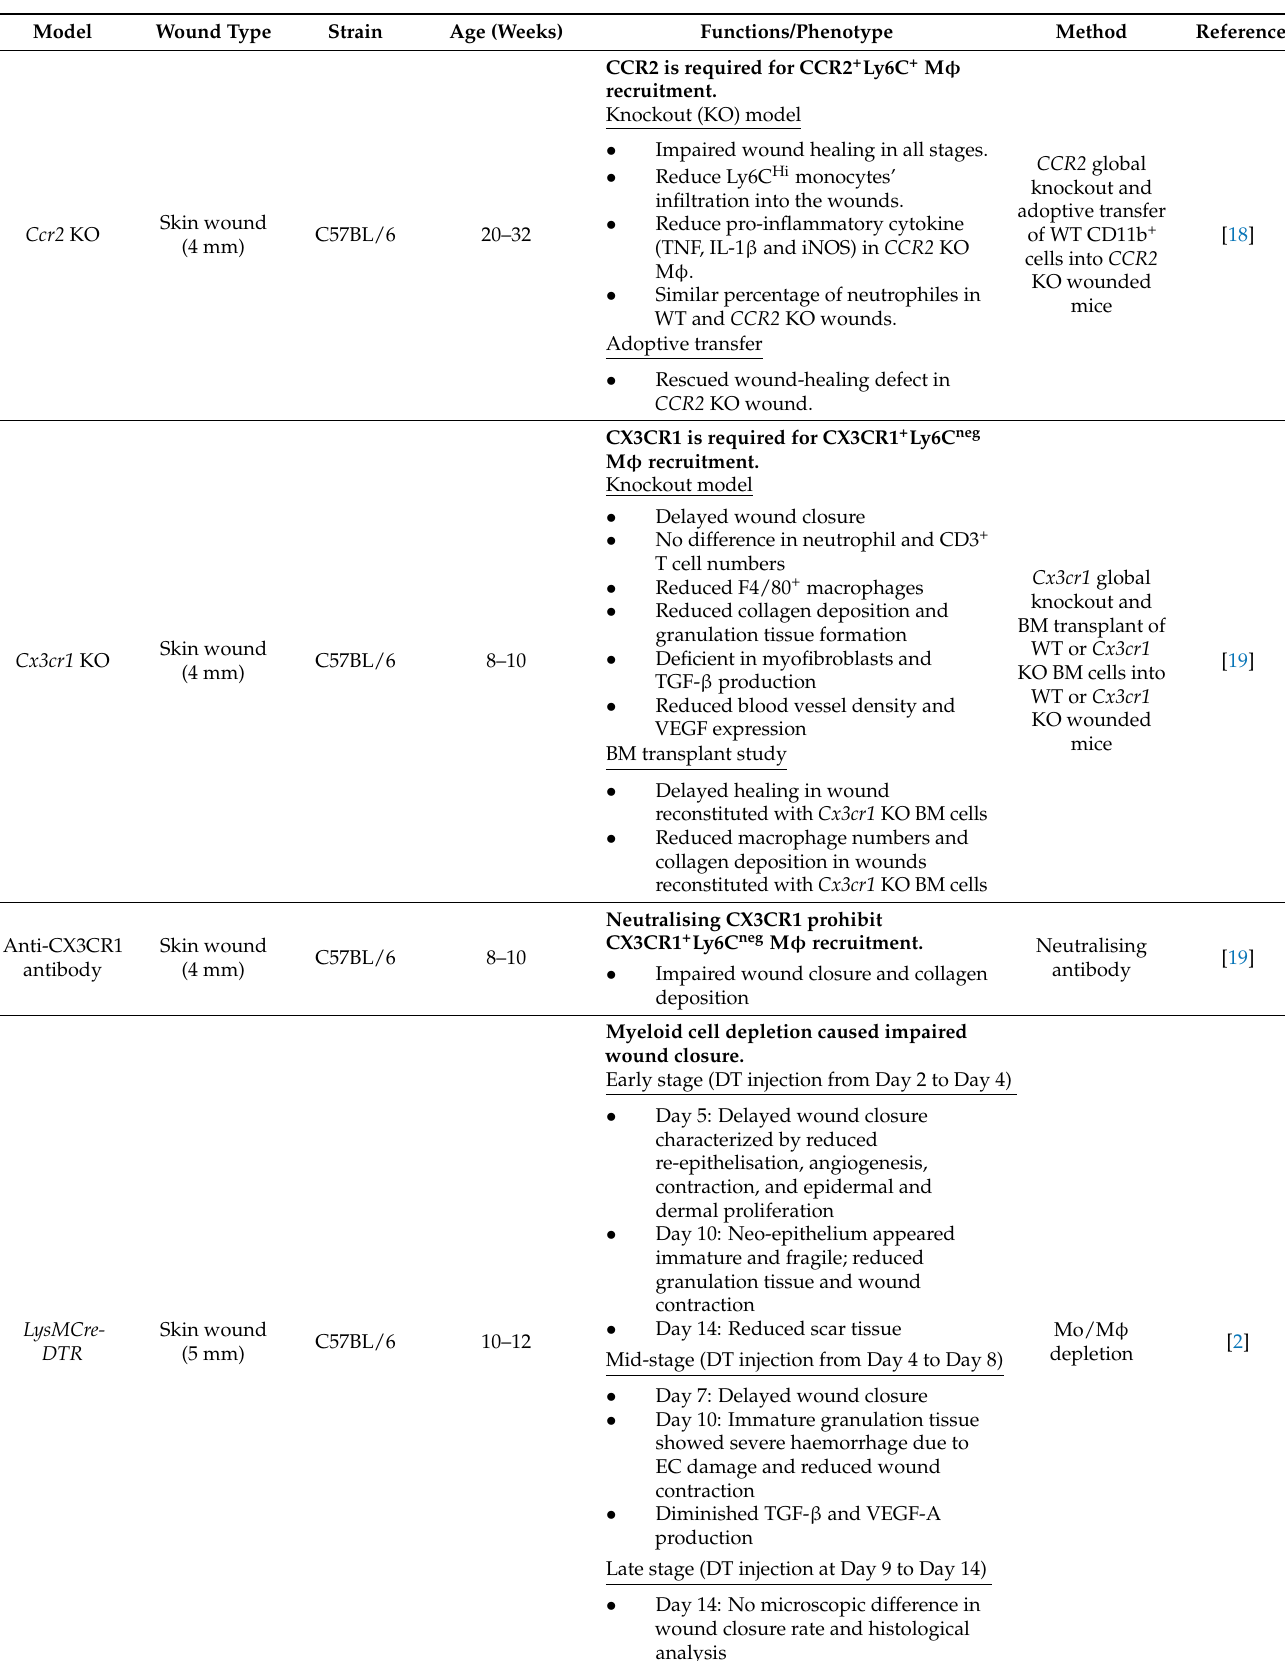
Table 1. Implications of myeloid/macrophage depletions on wound-healing